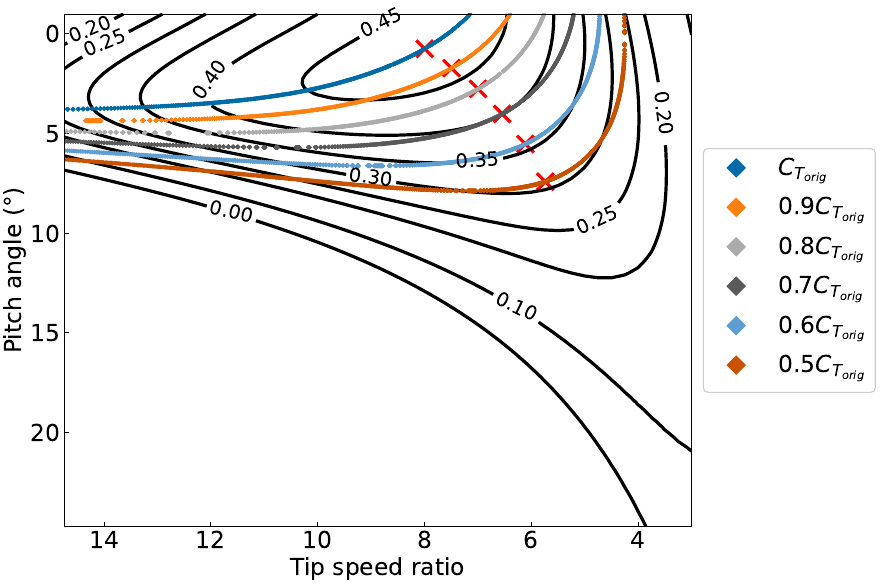
Figure 12. Contour plot of C P for the DTU 10 MW turbine, overlaid by the same coloured lines as in Figure 11 showing possible operating points for a given reduction in C T for Region